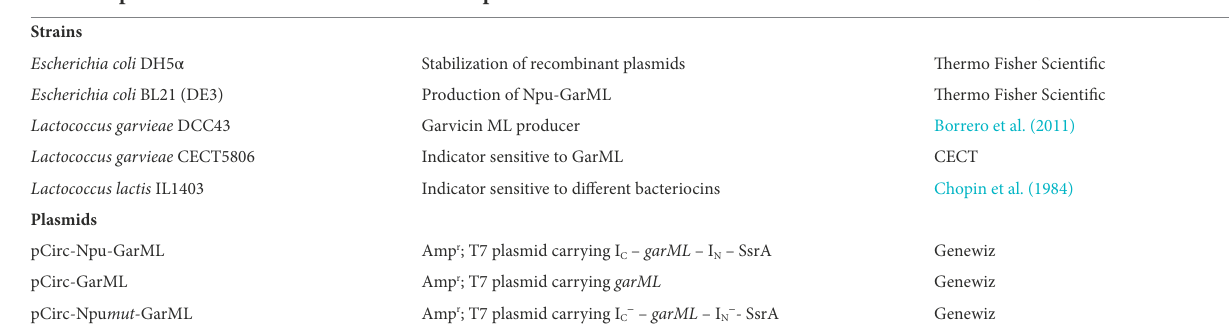
TABLE 1 Strains and plasmids used in this